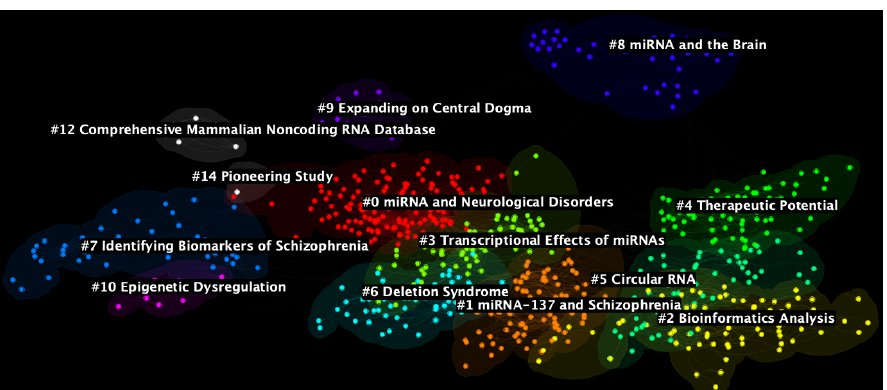
Figure 3. Document co-citation analysis network of all literature on micro RNA and schizophrenia with 13 generated clusters. The image was generated with CiteSpace software